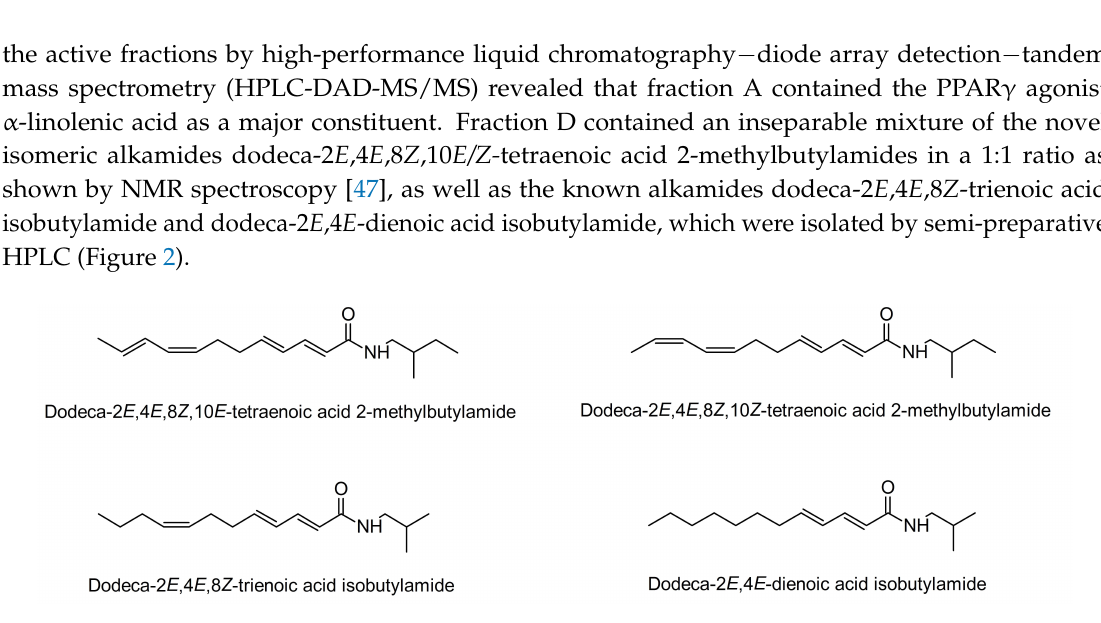
Figure 2. Chemical structures of alkamides isolated from an active fraction of a DCM root extract of Echinacea purpurea that demonstrated significant insulin-dependent GU activity.